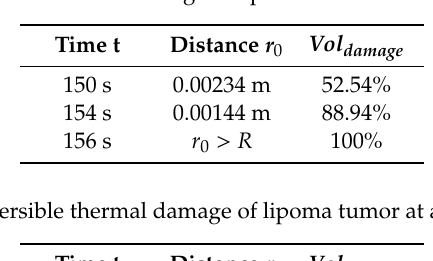
Table 6. The irreversible thermal damage of liposarcoma tumor at a voltage V = 78V.